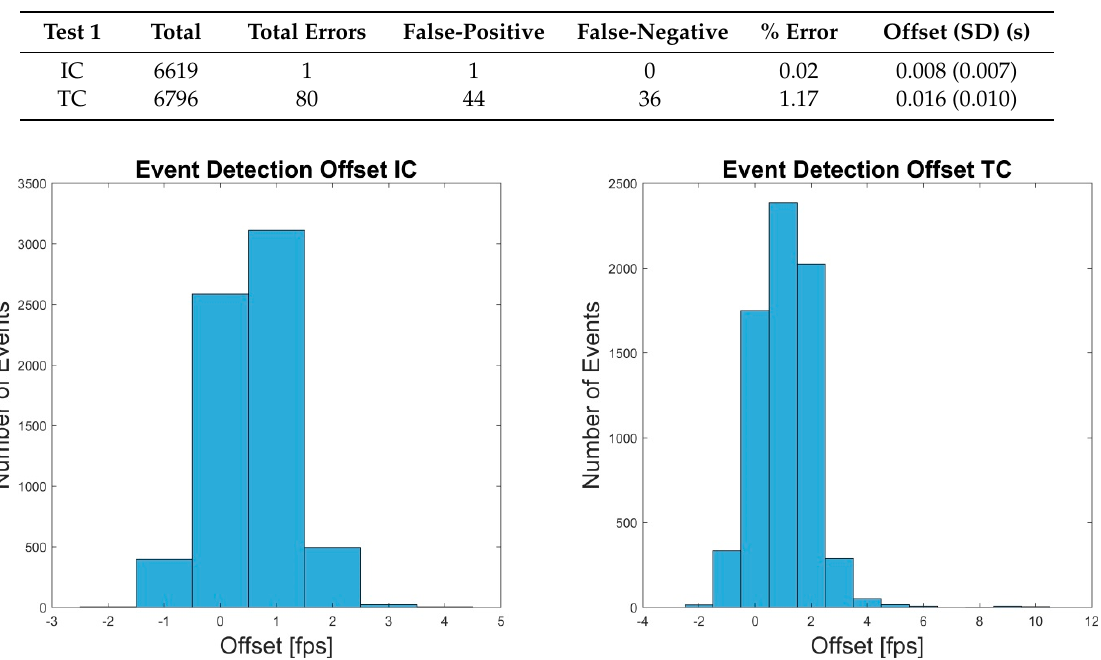
Table 2. Event-detection results for Test 1. The total of detected events, number of erroneous detections, false-positives and false negatives, percentage error and the offset between optical (OMC) and inertial measurement unit (IMU) system plus standard deviation (SD) are shown.